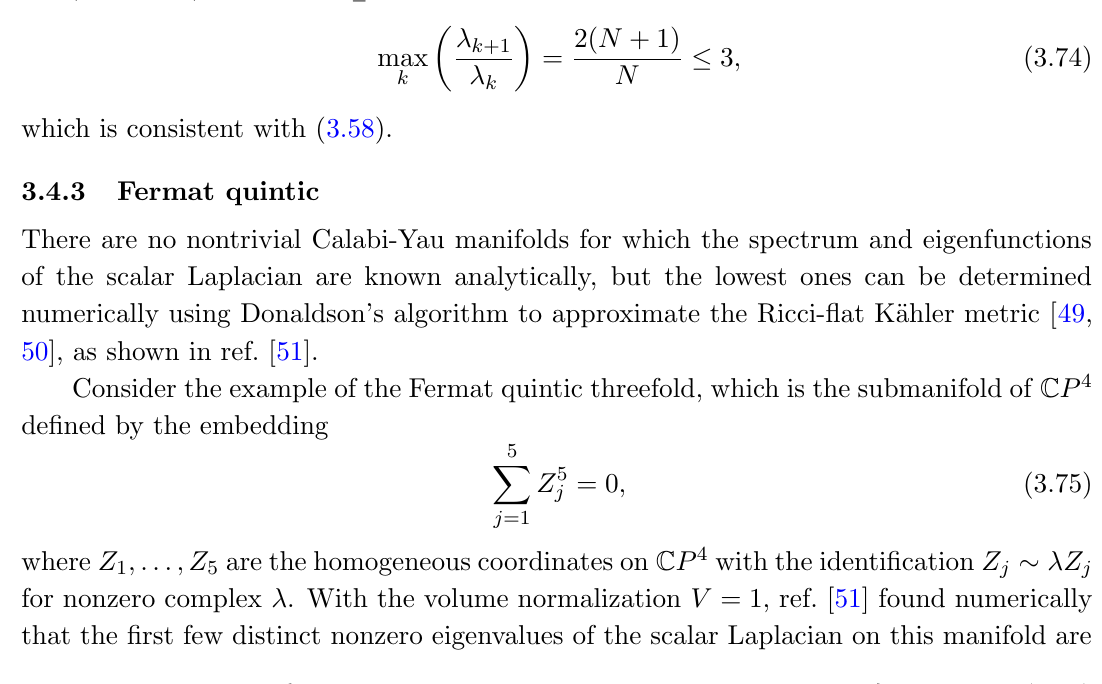
Figure 3 . The fundamental domain ( (cid:28) ) of the 2-torus with the shaded region showing tori whose F scalar Laplacian eigenvalues satisfy (cid:21) 2 = 4 (cid:21) 1 . internal space for a (cid:13)at compacti(cid:12)cation of GR. The possible scalar eigenvalues are